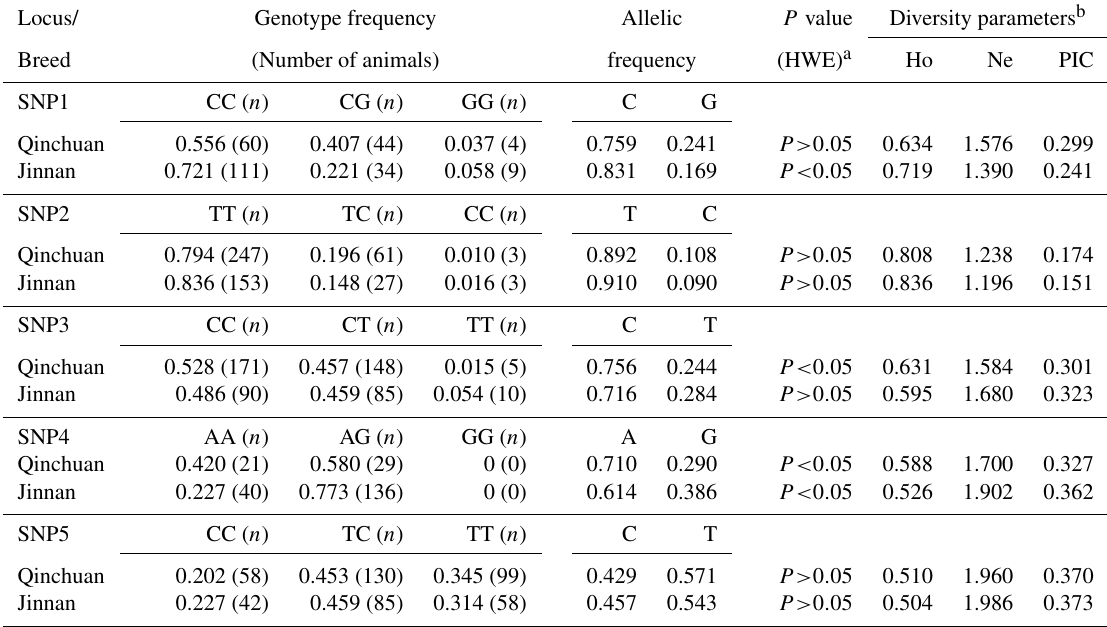
Table 3. Genotype, allelic distribution and genetic diversity of five SNP loci of the bovine ATBF1 gene. Locus/